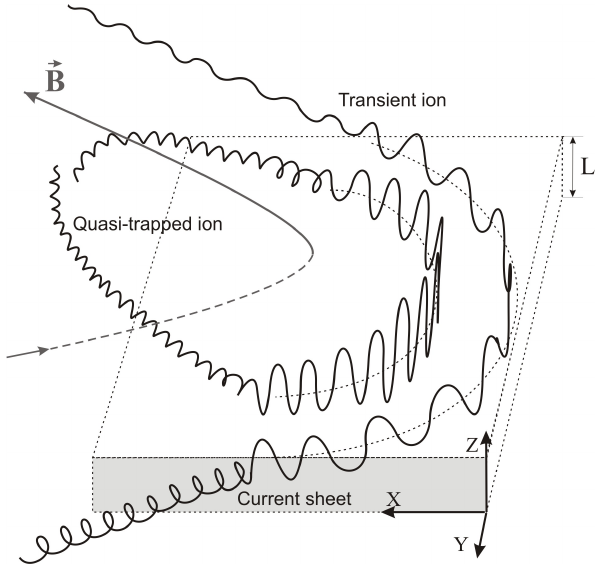
(red) and plasma density (green) profiles. (b) Current density in the single-component model (only transient ions) (red) and current density in the model with anisotropic electrons (blue). (c) Current density in the single-component model (only transient ions) (red) and current density in the model with isotropic electrons (blue). (d) Current density in the single-component model (only transient ions) and thicker profile (black) due to oxygen ions, trapped plasma or double-temperature